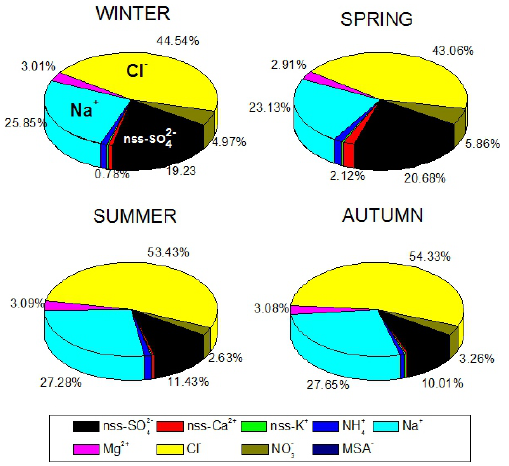
Figure 8. Percentage contribution of major ions to total water- soluble ions for different seasons.